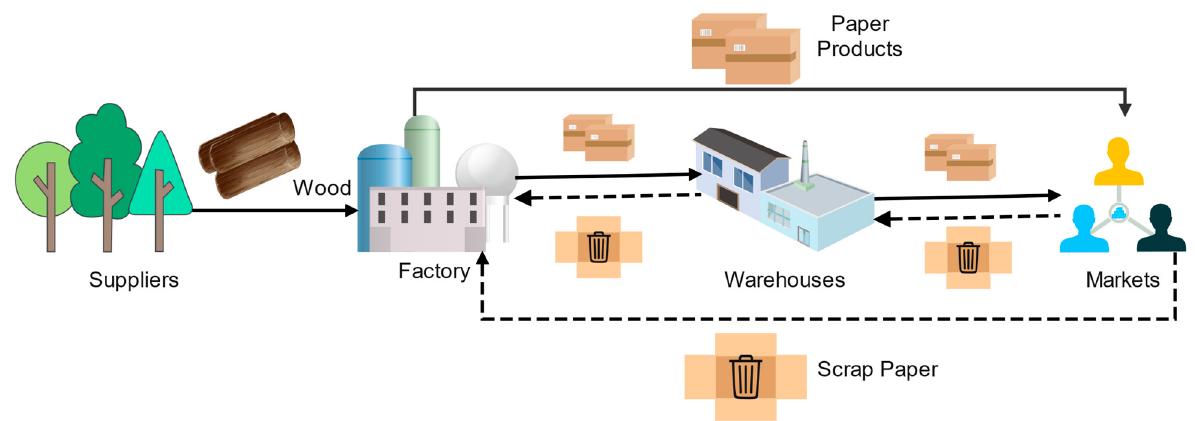
Figure 1. Schematic diagram of closed-loop supply chain network structure. Figure 1 consists of four levels: wood suppliers, paper product processing